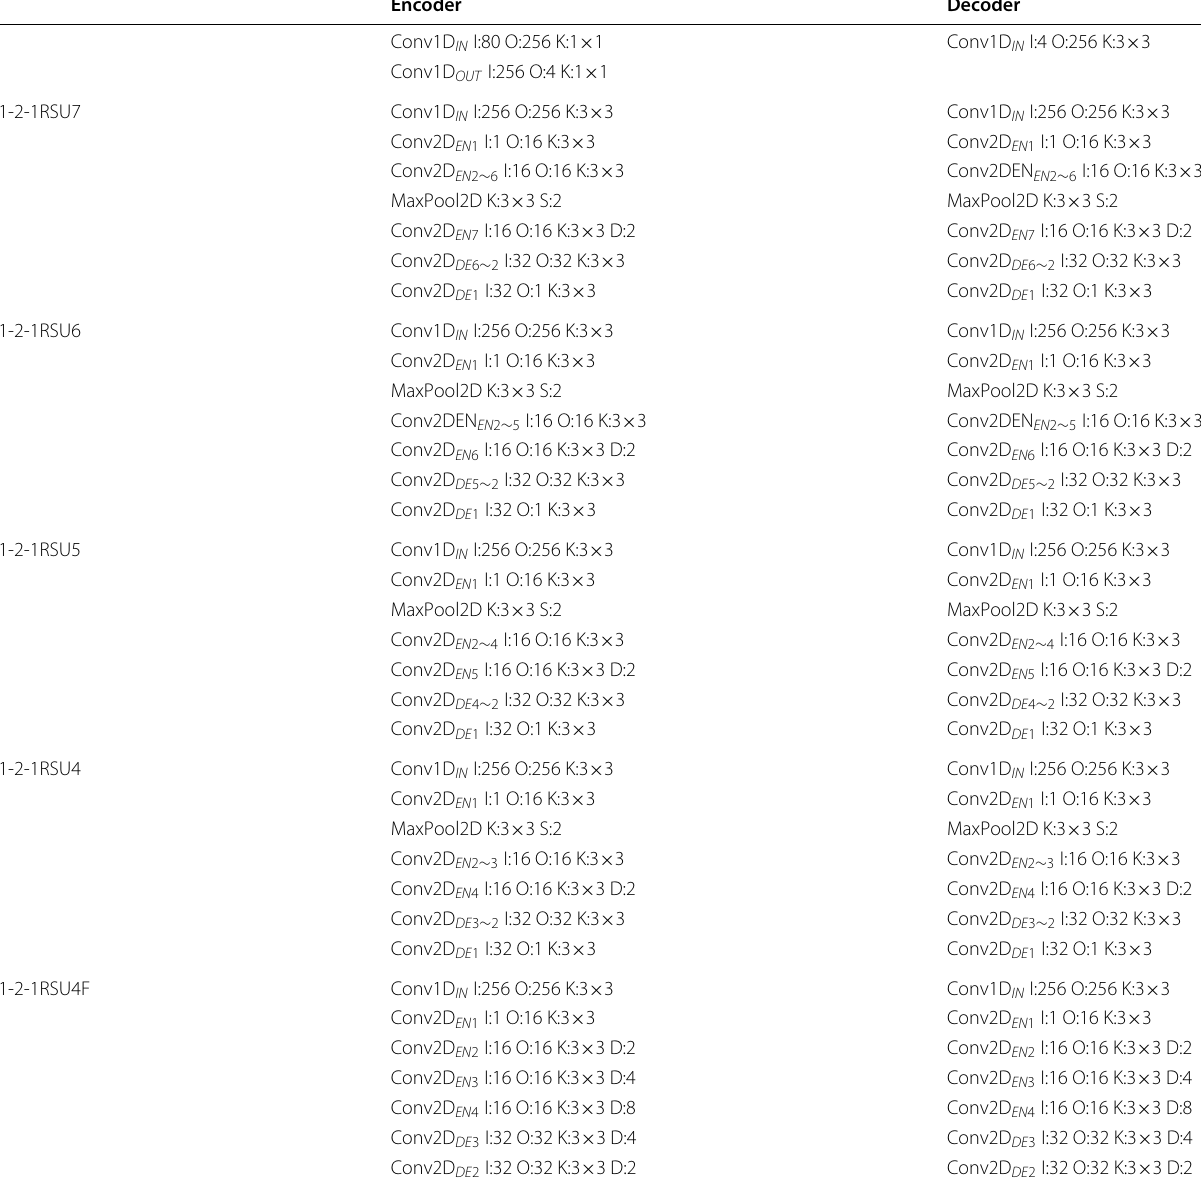
Table 1 Bold words represent the three parts of our U 2 -VC as noted in section 3. “I” denotes the input size. “O” denotes the output size. “K” denotes the kernel size. “S” denotes the stride. “D” denotes the dilation. “H” denotes the hidden size. “L” denotes the layer. As stated before, residual U-block has the same structure as original residual U-block except the input layer and the reshaping